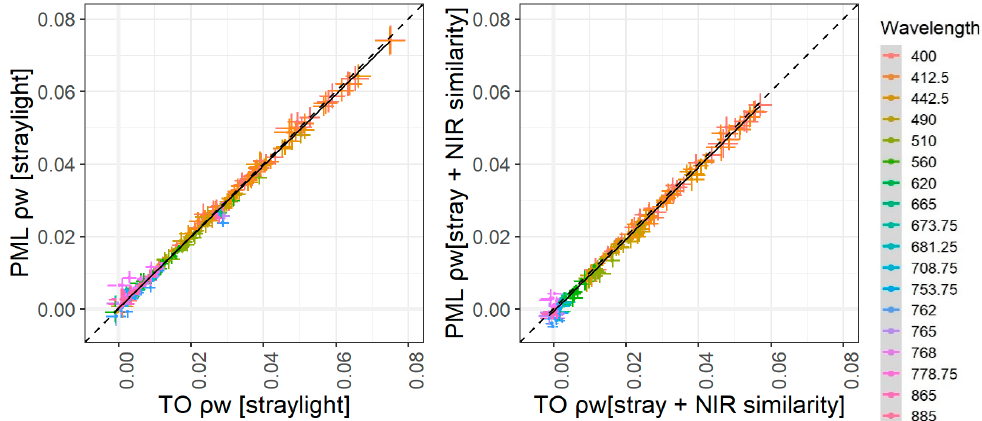
Figure 11. Comparison between TO and PML ρ w after straylight (left) and straylight + NIR similarity correction over all OLCI’s band. The comparison at each band can be found in Figure A4 for straylight correction and in Figure A5 for straylight + NIR similarity correction.